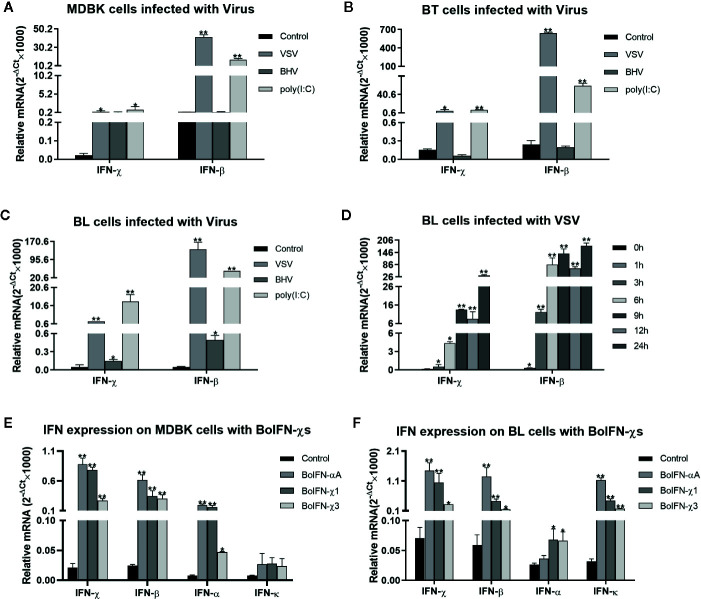
Transcription analyses of BoIFN-χs. (A–C) Transcription analyses of BoIFN-χs induced by viruses in MDBK/BL/BT cells. VSV (0.1 MOI), BHV (0.1 MOI), and poly(I:C) (1 μg/mL) were separately infected or transfected the cells for 6 h; the cells without treatment were used as control, and then, the RNAs were collected for qPCR. (D) Time dependence of BoIFN-χs transcription induced by the VSV in BL cells. VSV (0.01 MOI) were separately infected BL cells at different times, the cells without VSV infection were used as control, and then, the RNAs were collected for qPCR. (E, F) Transcription analyses of type-I IFNs regulated by BoIFN-χs in MDBK/BL cells. BoIFN-χ1 (5 μg/mL) and BoIFN-χ3 (5 μg/mL) were incubated in cells for 6 h, and BoIFN-αA (5 μg/mL) was used as positive control, and the cells without IFN incubation were used as mock-treated control. Data are the mean ± SD (n = 3) of one representative experiment. *P < 0.05, **P < 0.01.